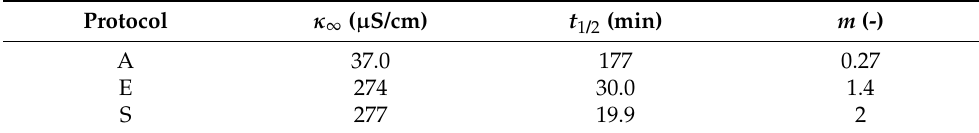
Table 4. Release kinetics parameters of the different